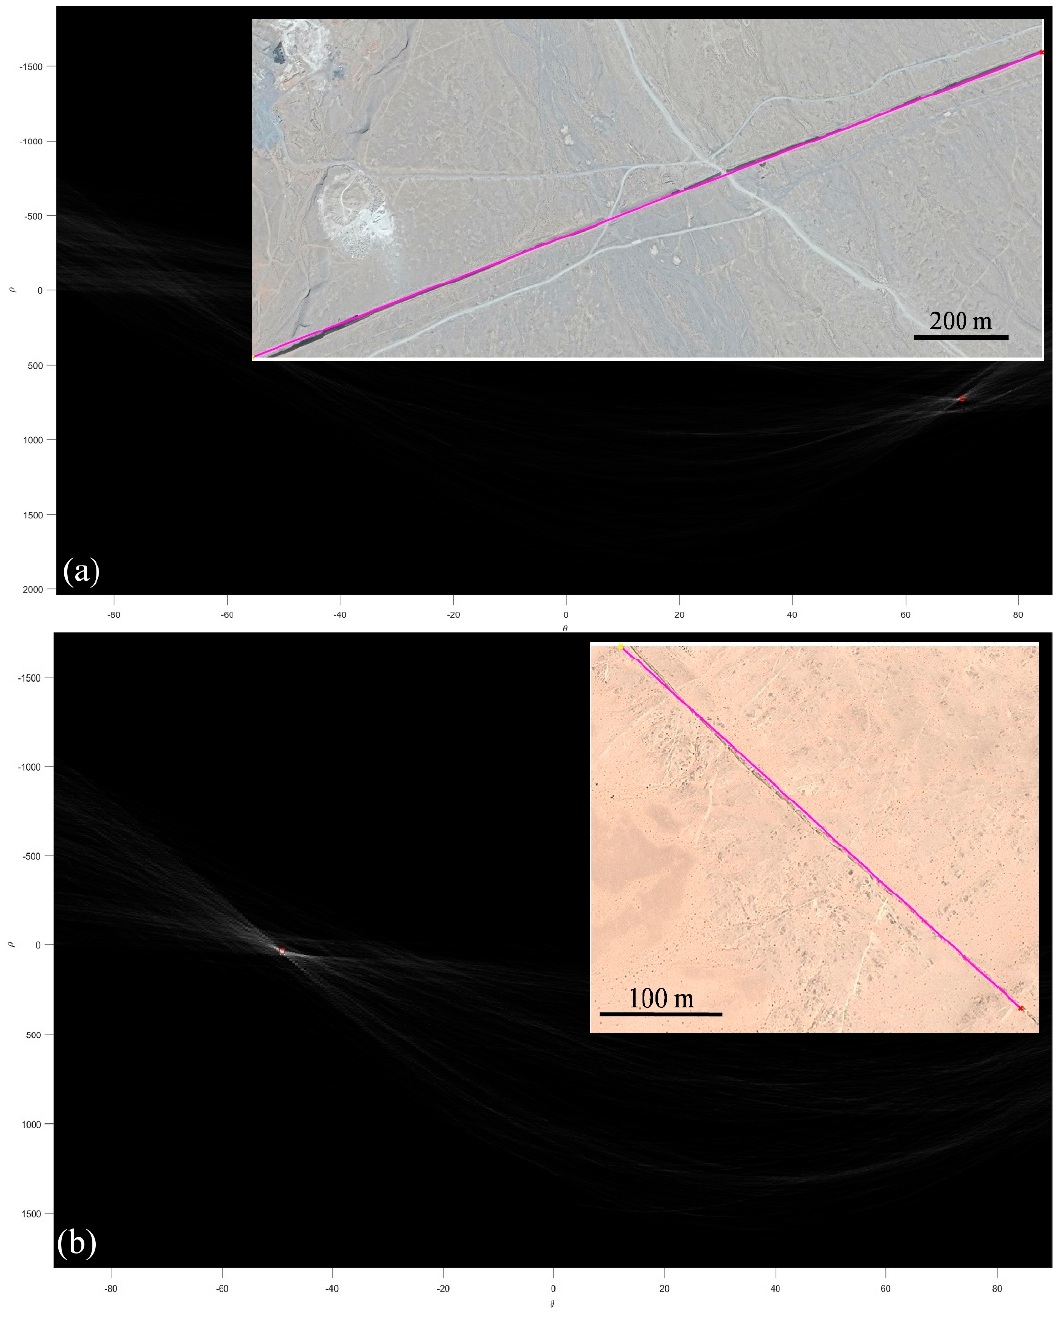
Figure 11. Application of the proposed method to Google Earth very high-resolution (VHR) images in order to identify linear traces of the Ming generation of the Great Wall in Heaton Corridor ( a ), (105°47 ′ 42 ″ E, 38°12 ′ 55 ″ N)) and the Western Xia generation in Inner Mongolia ( b ), (106°01 ′ 34 ″ E, 41°43 ′ 03 ″ N)).